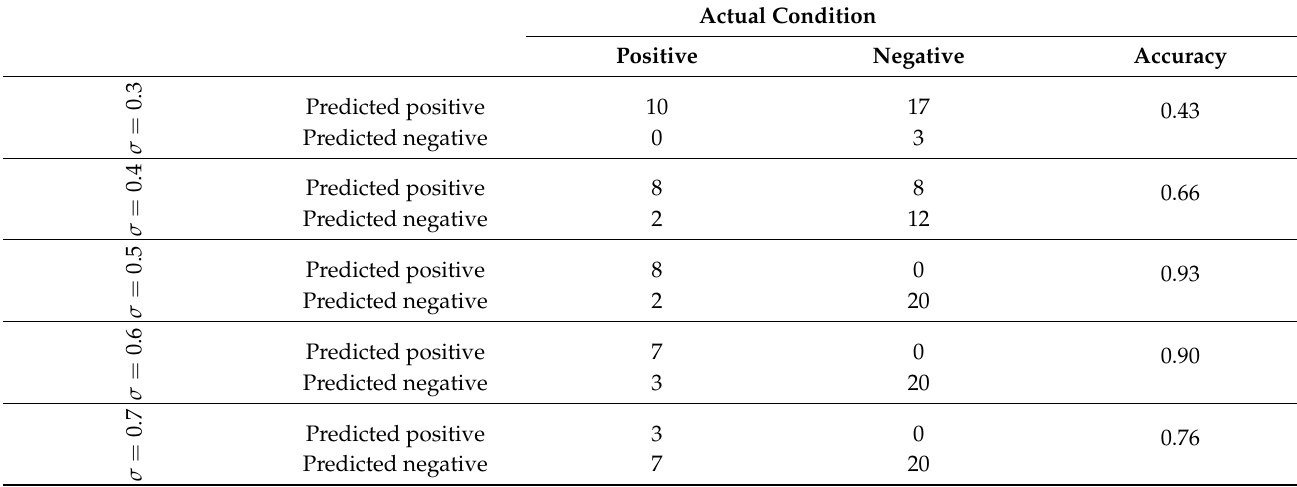
Table 3. Confusion matrix and accuracy of each threshold level in the attack to an AIS/ECDIS